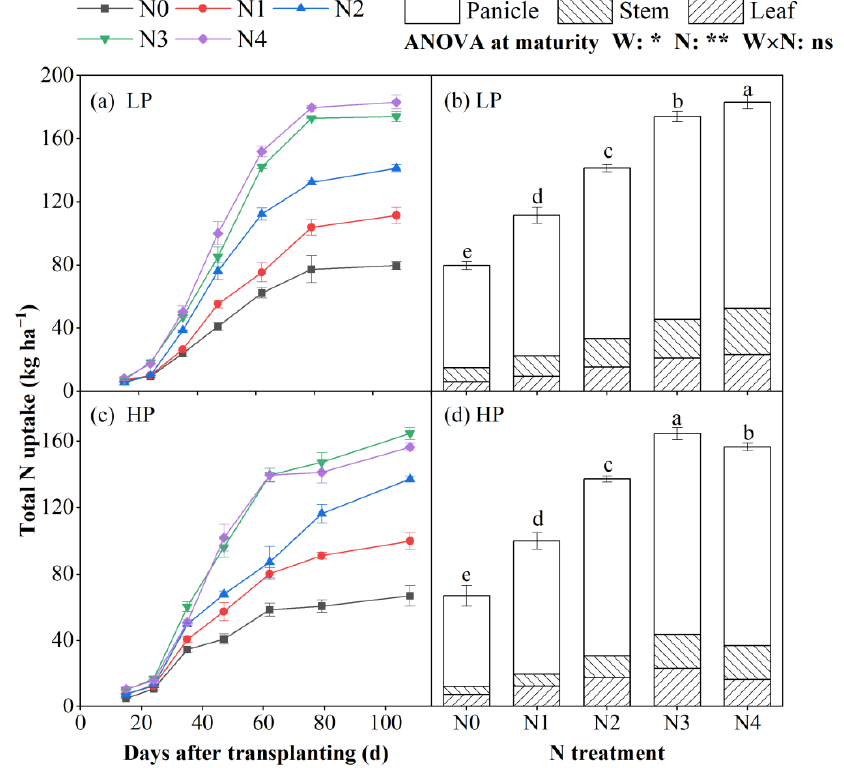
Figure 6. Dynamic of total nitrogen uptake ( left , ( a , c )) and TN accumulation in various organs of rice at maturity ( right , ( b , d )). Different letters next to means denote significant differences based on Least Significant Difference test (LSD test, p < 0.05). * and ** denote significant at 0.05 and 0.01 levels, respectively, while ns is non-significant ( p > 0.05). LP and HP, i.e., low percolation and high perco- lation, represent two deep percolation rates controlled by the lysimeters, 3 mm d −1 and 5 mm d −1 , respectively. N0~N4 represent 0, 60, 135, 210 and 285 kg N ha −1 application, respectively. The AE varied between 16.2 and 25.3 kg kg −1 at LP and between 16.5 and 26.5 kg kg −1 at HP (Table 4). AE was highest in N1 and lowest at N4 and showed no significant differ- ence between N2 and N3 under both water treatments. In addition, PE varied between 44.6 and 52.8 kg kg −1 at LP and between 41.8 and 52.5 kg kg −1 at HP. Changes in PFP were consistent with those in RE under both water treatments. In general, AE , PFP and RE re- duced with the increase of N application from N1 to N4 under both water treatments, but the significance of the difference was inconsistent. For the LP and HP regimes, the AE of N4 treatment was 31.8% and 26.9% lower than that of N3, and the PFP of N4 treatment was 28.5% and 26.5% lower than that of N3, respectively. According to the results of ANOVA, the yield and WP of N3 and N4 were greater than those of N2, whereas the differences were non-significant, indicating that the marginal benefit of N-fertilizer input increment was decreasing. However, based on the indicators of NUE , N2 had higher AE, PFP and RE than N3 and N4; in particular, the differences in NUE indicators between N2 and N4 reached a significant level. For the LP and HP regimes, the highest N uptake and WP were obtained with N application levels of 285 kg ha −1 and 210 kg ha −1 , respectively. In addition, either water or N showed significant effects on PFP , but no significant inter- action effects of W × N were observed on AE , PE , PFP and RE .